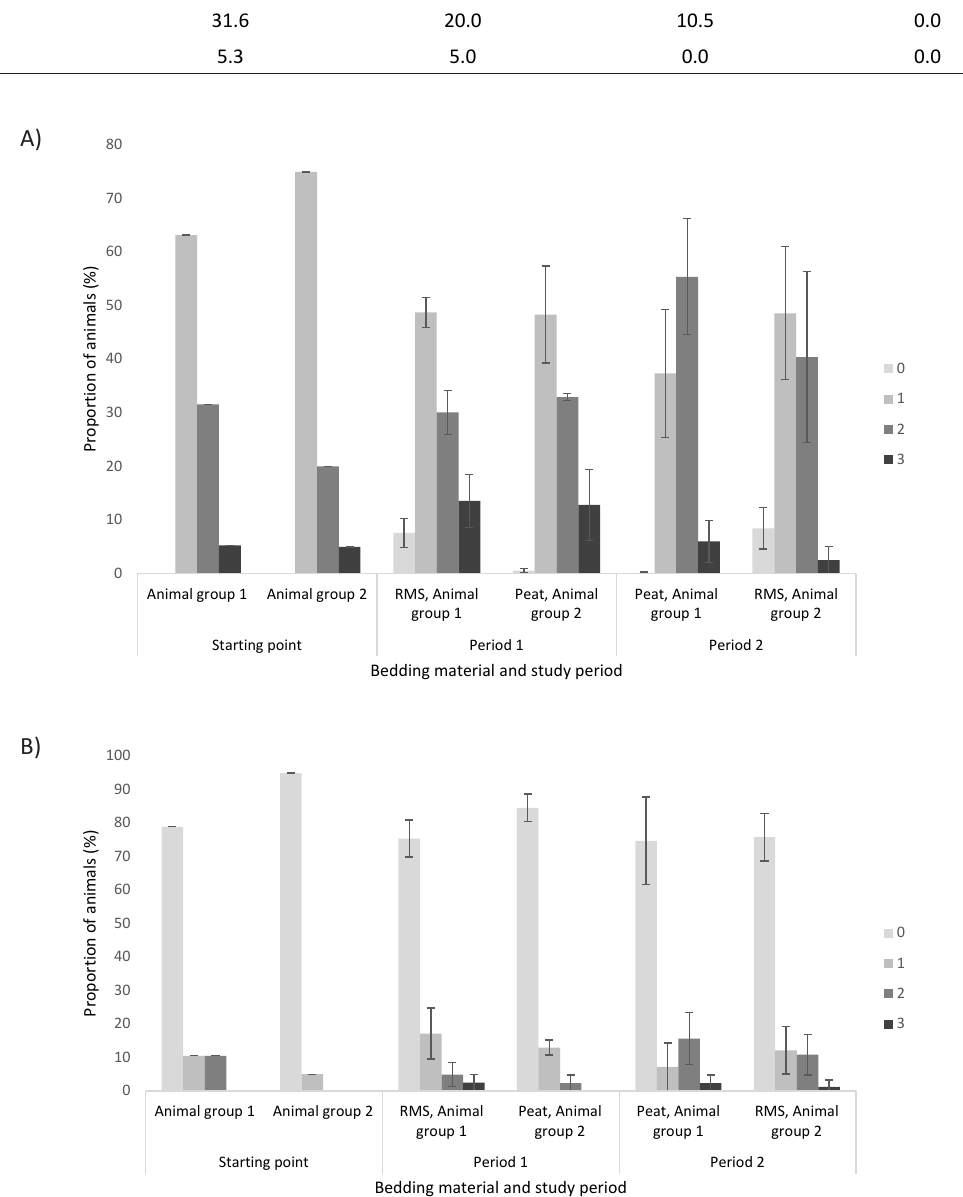
Fig. 1. The proportion (%) of the cows in different integument alteration classes (0–3) for tarsal (A) and carpal (B) joints at the beginning of the experiment, and with studied bedding materials during two study periods. During the first study period RMS was used as bedding in the animal group 1 and peat in the animal group 2, and then vice versa for the second study